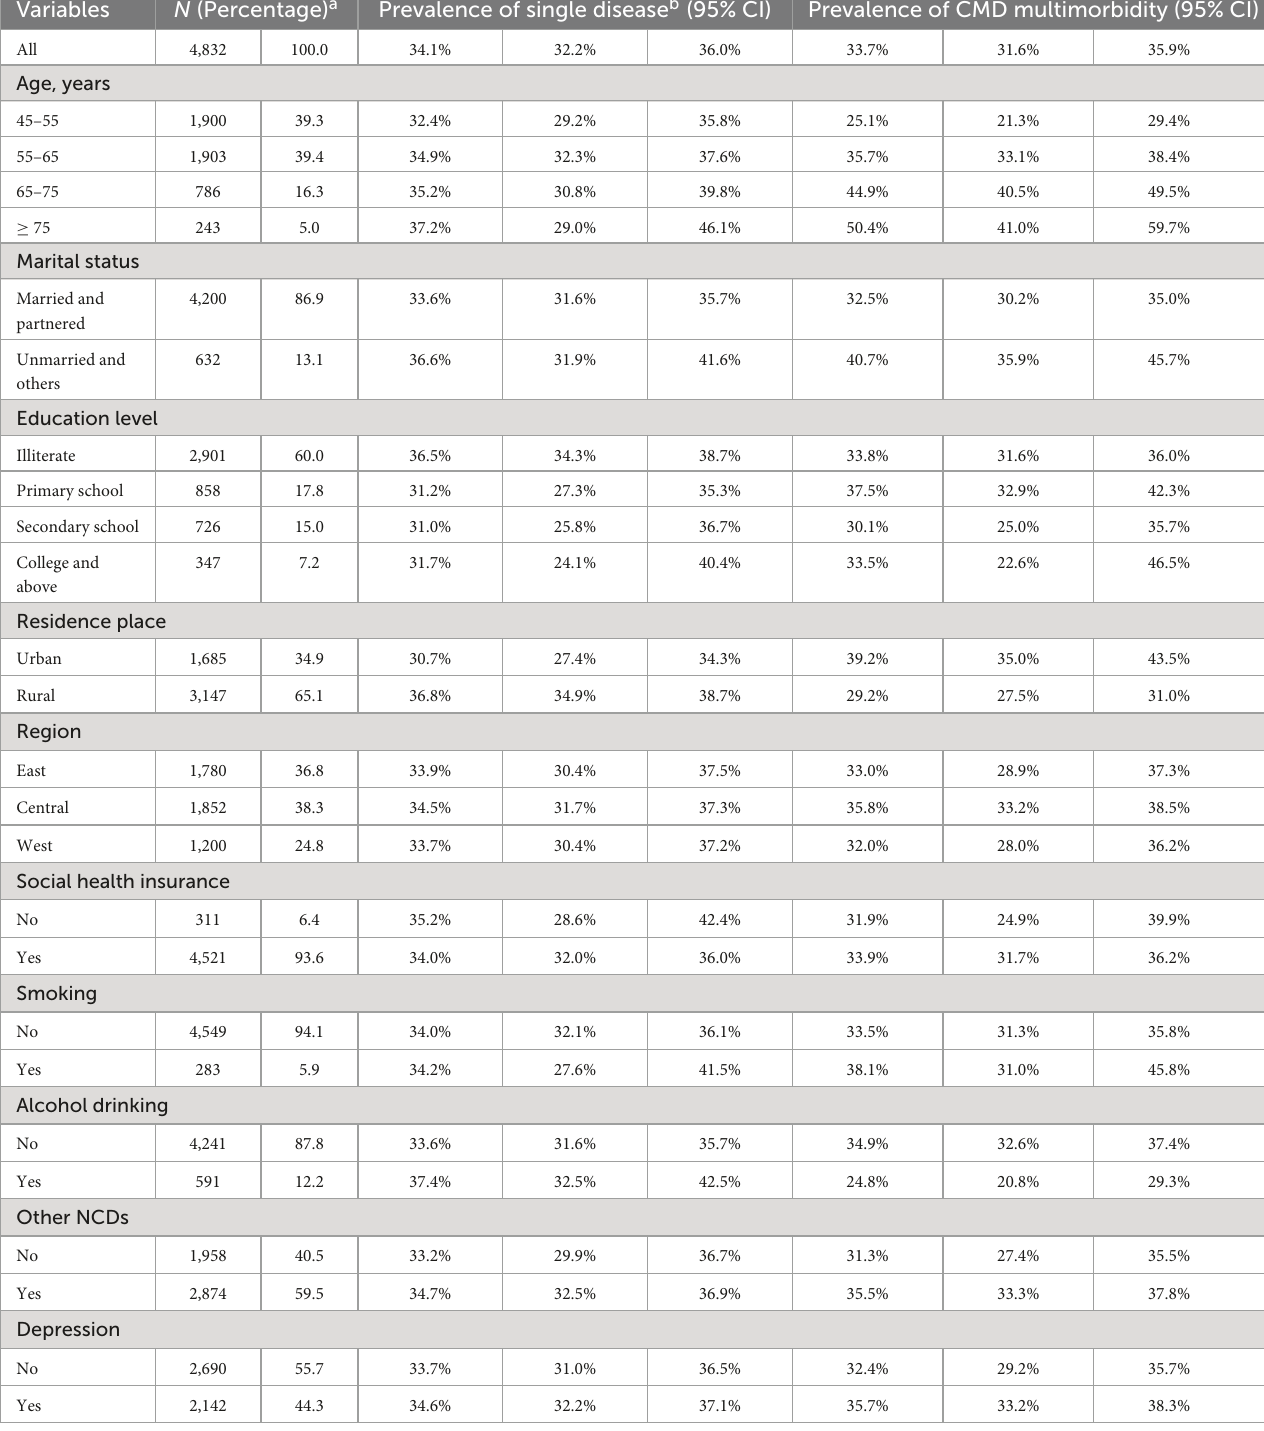
TABLE 1 Characteristics of participants, the prevalence of single condition and CMD